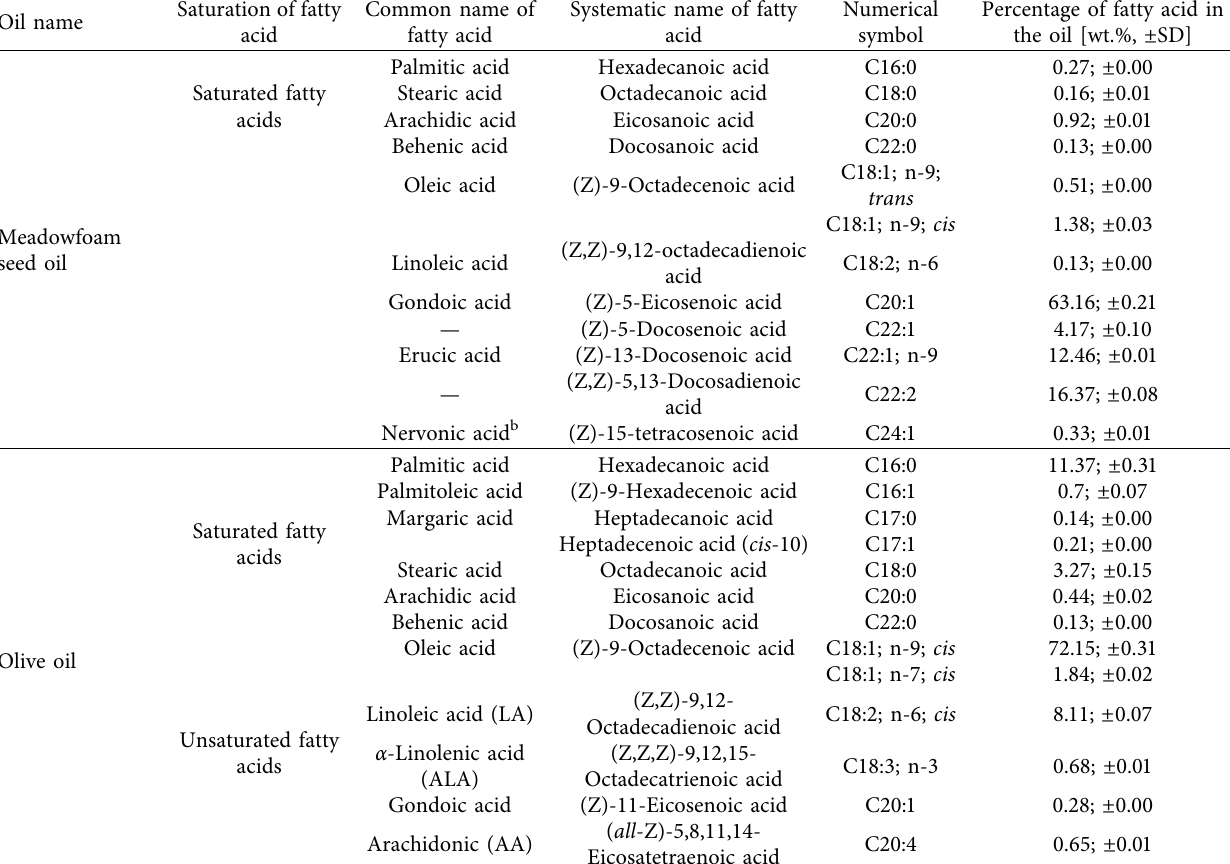
Table 1: The composition of fatty acids of MSO and of olive oil [source: own